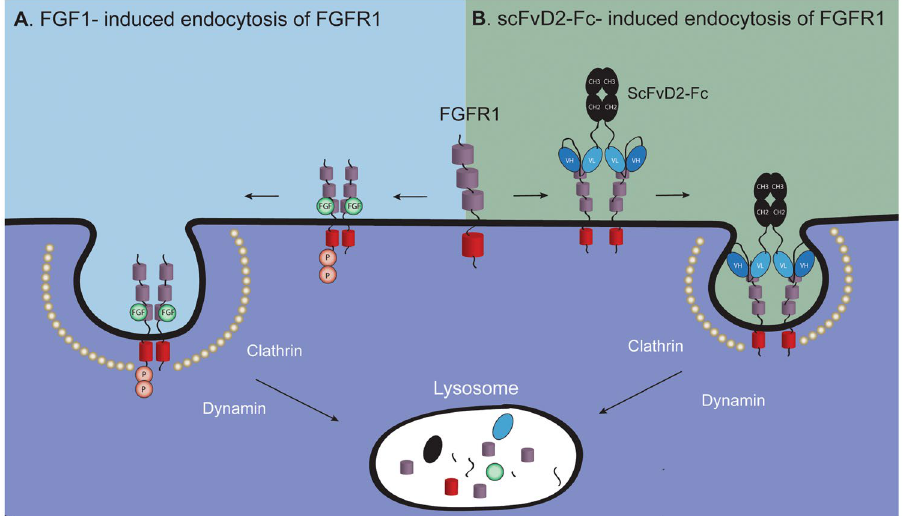
Figure 7. The model of the growth factor- and bivalent antibody-induced endocytosis of FGFR1. ( a ) FGF1 binds to the D2 and D3 domains of FGFR1 and induces FGFR1 dimerization. The conformational change within FGFR1 in the receptor dimer leads to the activation of FGFR1 kinase domain that results in receptor activation by transphosphorylation. Activated FGFR1 recruits intracellular signaling proteins and this results in the initiation of downstream signaling cascades. To downregulate the FGFR1-dependent signals FGFR1 dimer is sequestered into clathrin-coated vesicles and internalized into the cells via CME that requires dynamin. Subsequently FGFR1-containing endosomes are delivered for the lysosomal degradation. ( b ) The bivalent scFvD2-Fc antibody interacts with the D1 domain of FGFR1, leading to receptor dimerization. However, the conformation of the FGFR1 dimer is distinct from the one induced by FGF1, as there is no receptor activation. FGFR1 dimerization likely constitutes the signal for internalization of antibody-receptor complexes, as only bivalent antibody fragments are internalized. Next steps of scFvD2-Fc internalization, similarly to FGF1, employs FGFR1-mediated, clathrin and dynamin-dependent endocytosis. The scFvD2-Fc-FGFR1 complexes are finally degraded, likely in the